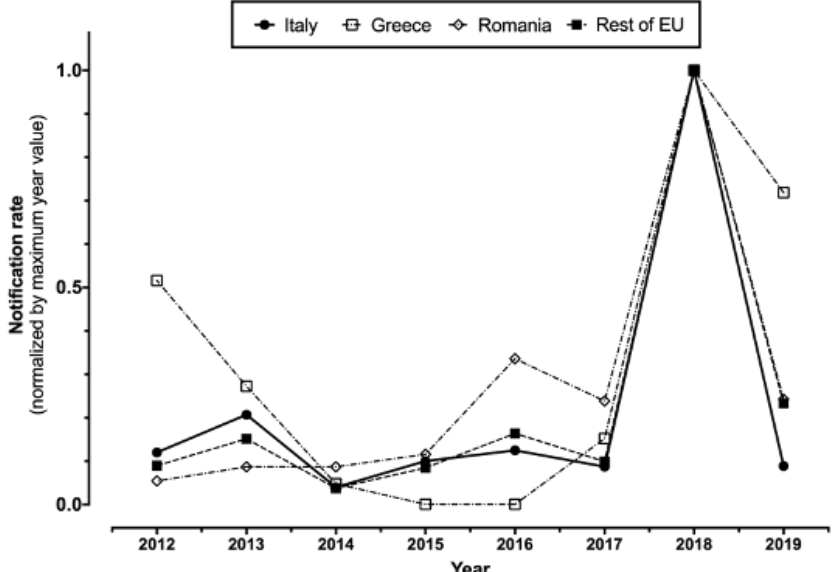
Figure 1. Notification rates percent normalized by maximum year value in Italy, Greece, and Romania compared to the rest of European Union (2012–2019, data were retrieved from ECDC Surveillance Atlas of Infectious Diseases (https://atlas.ecdc.europa.eu/public/index.aspx; accessed on 23 April 2021)). The majority of new cases of WNND occurred in August (56.7%), followed by Septem- ber (27.5%), July (14.0%), and October (1.4%), with only one case reported in June and November (Figure